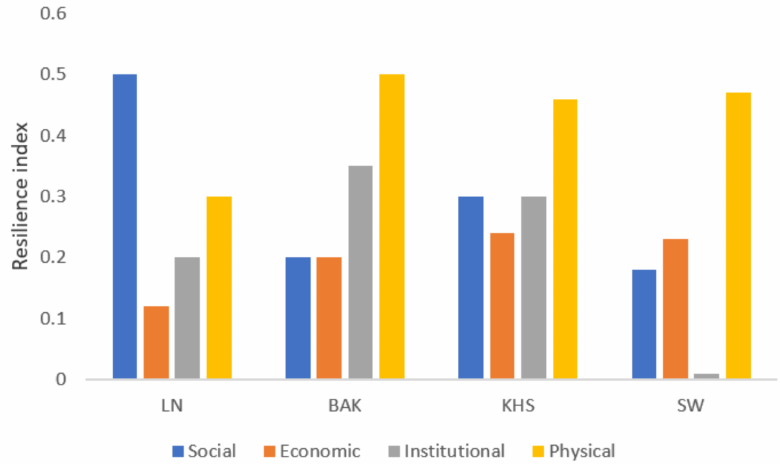
Figure 17. Comparison of resilience indices among the